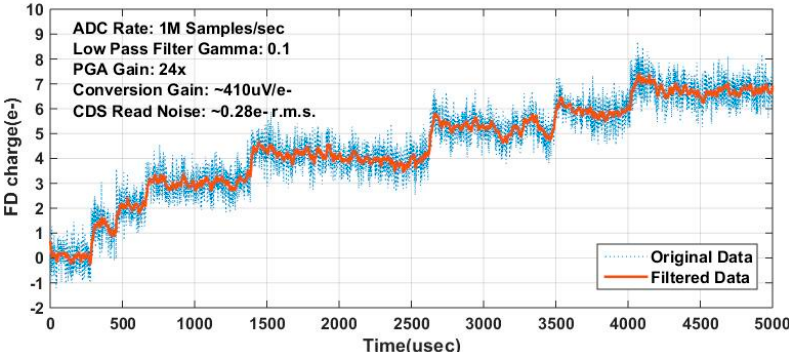
Figure 13. Illustration of photoelectron counting. The signal is the continuously sampled FD voltage from a TPG jot (with 0.28 e − r.m.s. read noise when operated in a CDS mode.) The FD voltage was changed by photoelectrons from SW (and possibly dark generated electrons.) Each single electron generates a fixed voltage jump on FD, and with deep sub-electron read noise, the electron quantization effect is visible.